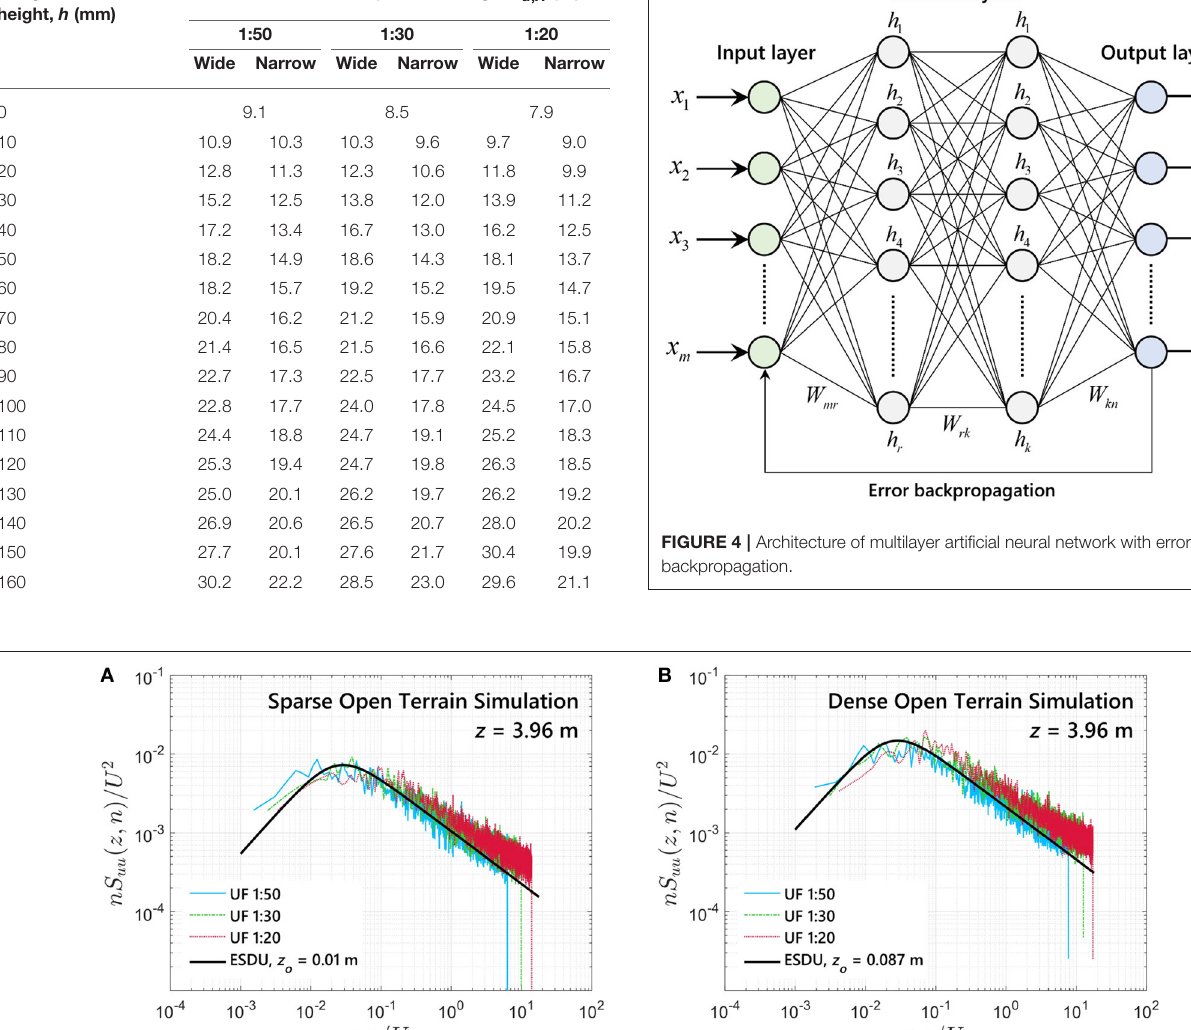
TABLE 1 | Longitudinal turbulence intensities of the freestream measured at the eave height of the 1:50, 1:30, and 1:20 building models. Roughness element height, h (mm)